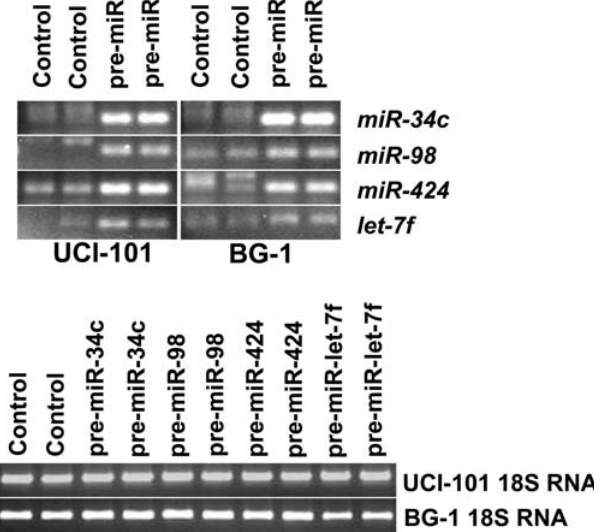
Figure 4. Forced overexpression of selected miRNAs in ovarian cancer cell lines. Pre- miR-34c , Pre-miR-98 , Pre- miR-424 , Pre- let-7f were overexpressed in BG-1 and UCI-101. The products for each of the miRNAs is shown in duplicate for the two cell lines used. Significant overexpression of the miRNAs is confirmed. RT-PCR of 18S RNA is shown for each condition to demonstrate equal loading.